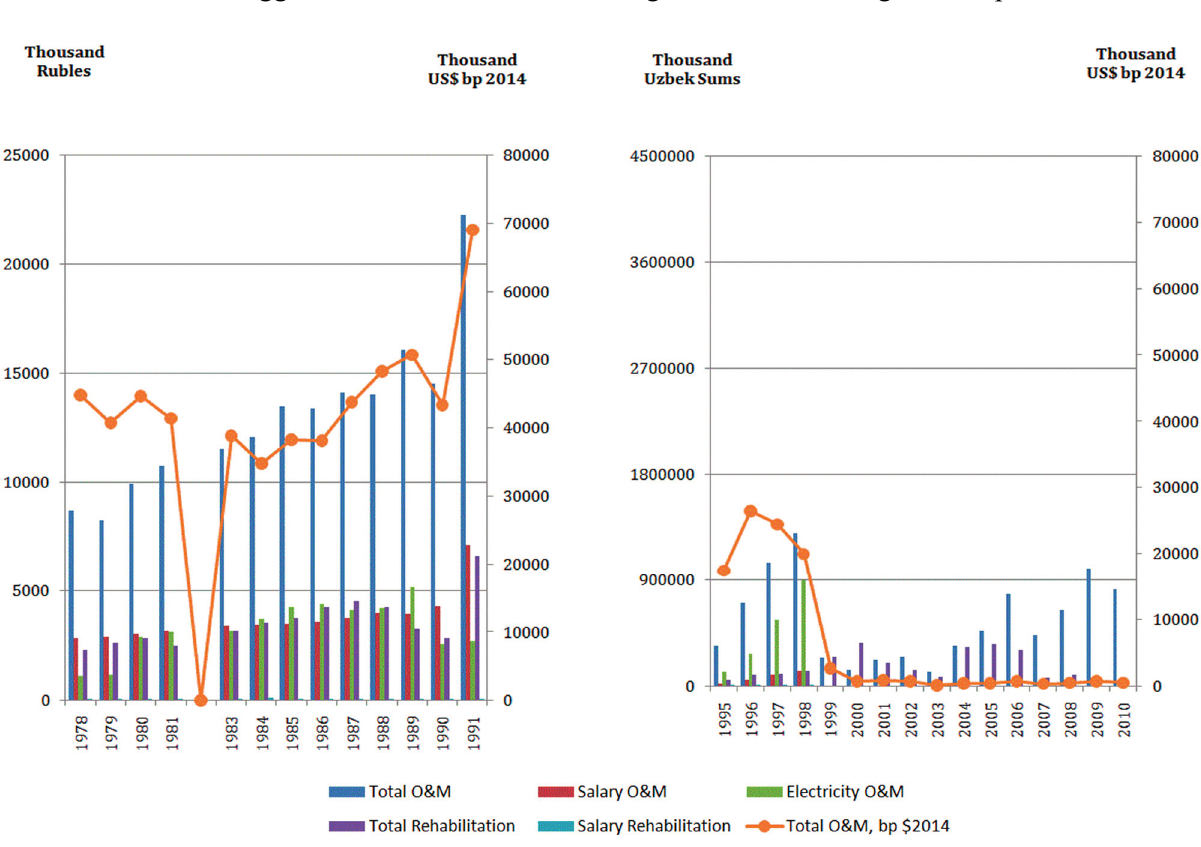
Figure 9. Expenditure for Operation and Maintenance and Rehabilitation (in 1,000 Soviet Union Rubles for the period 1978–1991 and 1,000 Uzbek Sums for the period 1995–2010, the secondary axis is in 1,000 USD buying power as of